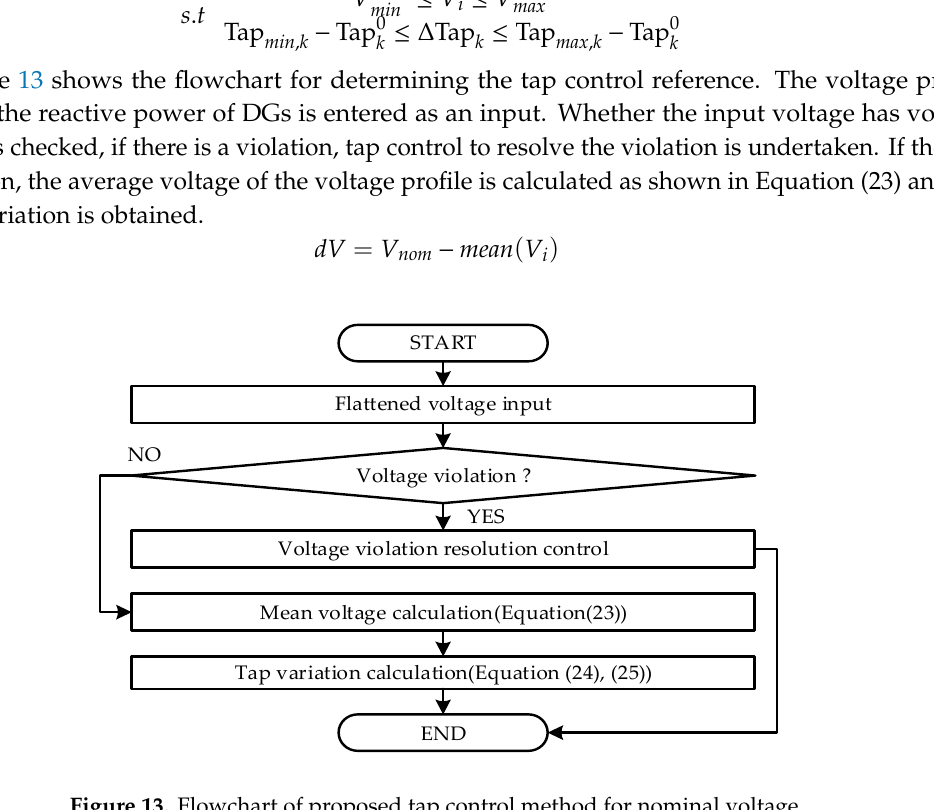
Figure 13. Flowchart of proposed tap control method for nominal voltage.